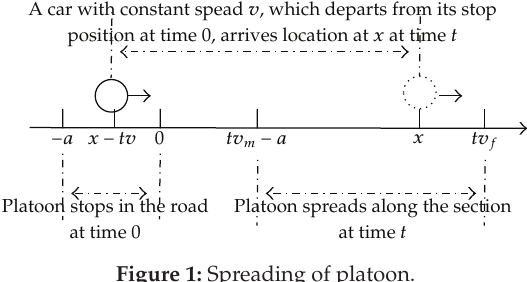
Figure 1: Spreading of